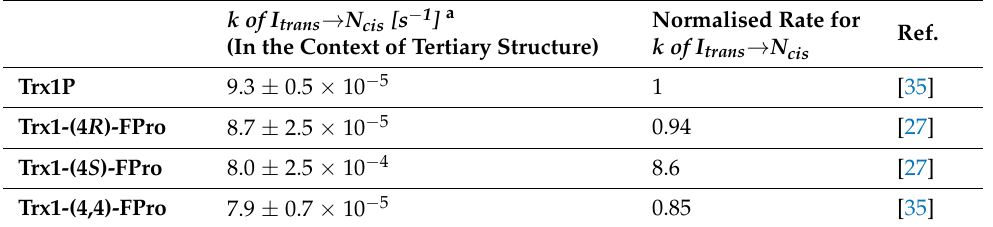
Table 1. Kinetic refolding parameters of Trx1P, Trx1-(4R)-FPro, Trx1-(4S)-FPro, and Trx1-(4,4)-FPro. k of I trans → N cis [s − 1 ] a (In the Context of Tertiary